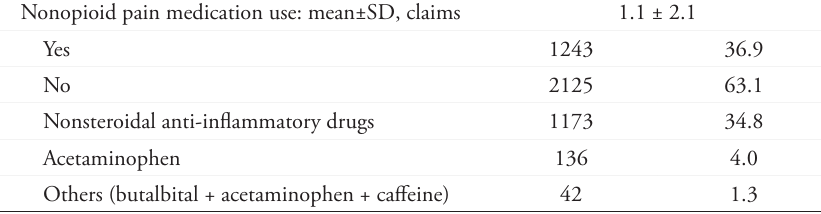
Table 4. Results of Negative Binomial Regression Examining the Association Between the Number of VOCs and the Number of Opioid Prescriptions Prescribed to Patients with SCD (N = 3368) 95% Confidence Limits IRR Number of VOC events